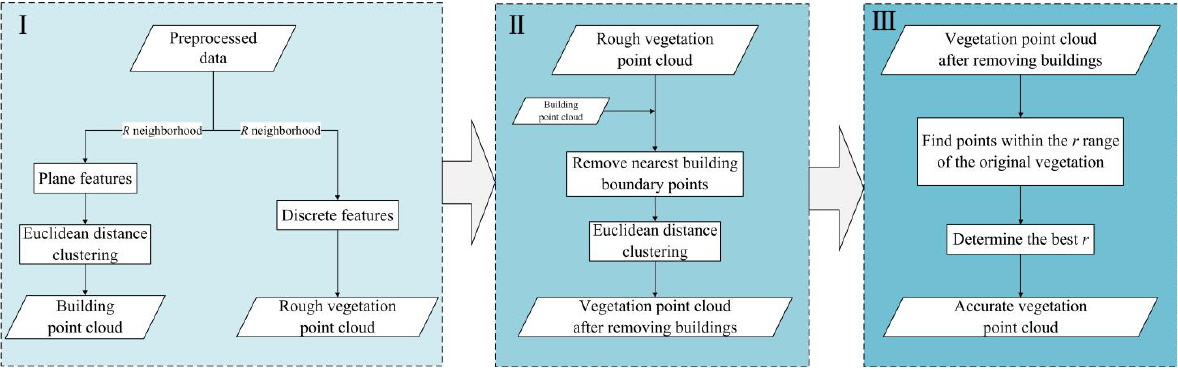
Figure 2. Vegetation and building point clouds. ( a ) Plot 1; ( b ) Plot 2.